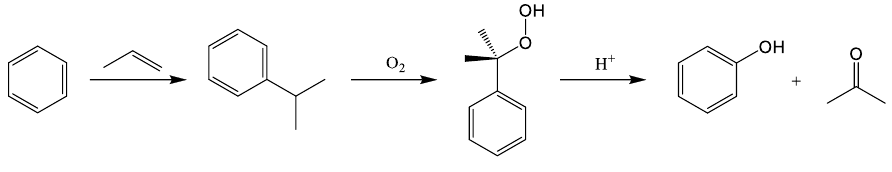
Figure 1. Cumene process. The decomposition named ‘Hock rearrangement’ is a Brønsted or Lewis acid catalyzed cleavage of a hydroperoxide, resulting in an alcohol and carbonyl compound, in case of